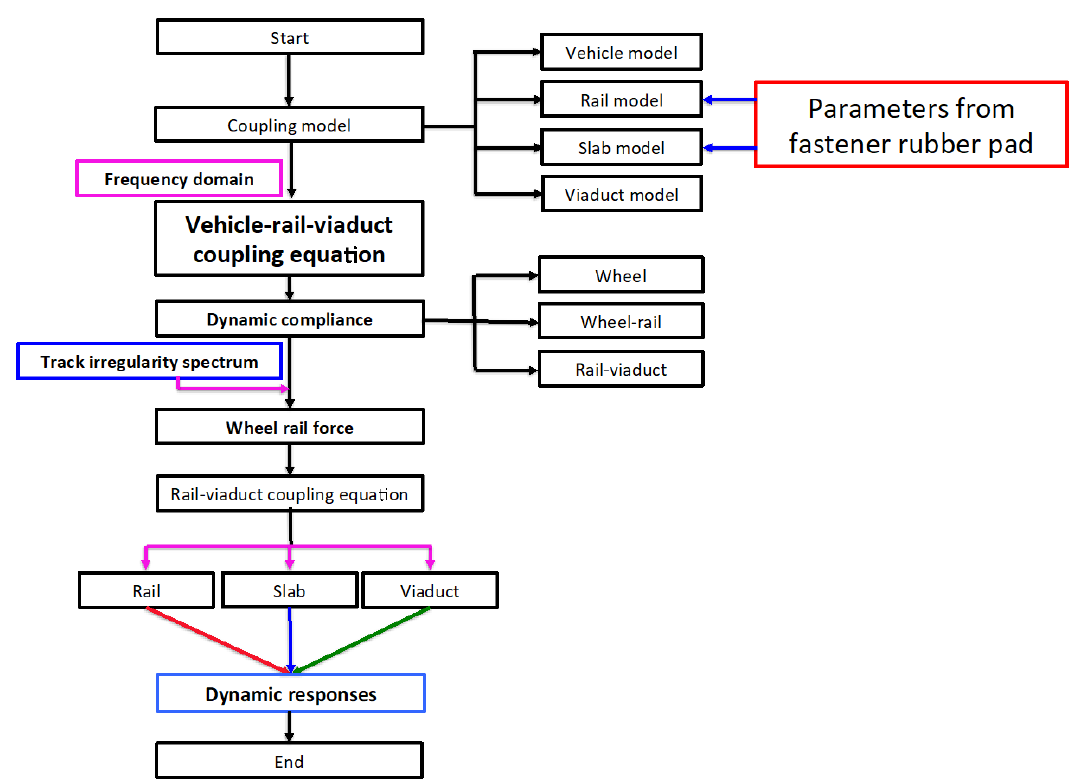
Figure 3. Flowchart for the vehicle-rail-slab coupled system dynamic analysis.